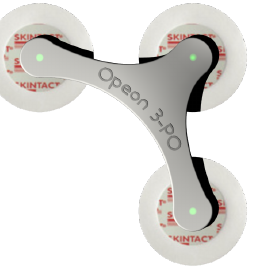
Figure 10. Cortrium heart rate monitor [13].